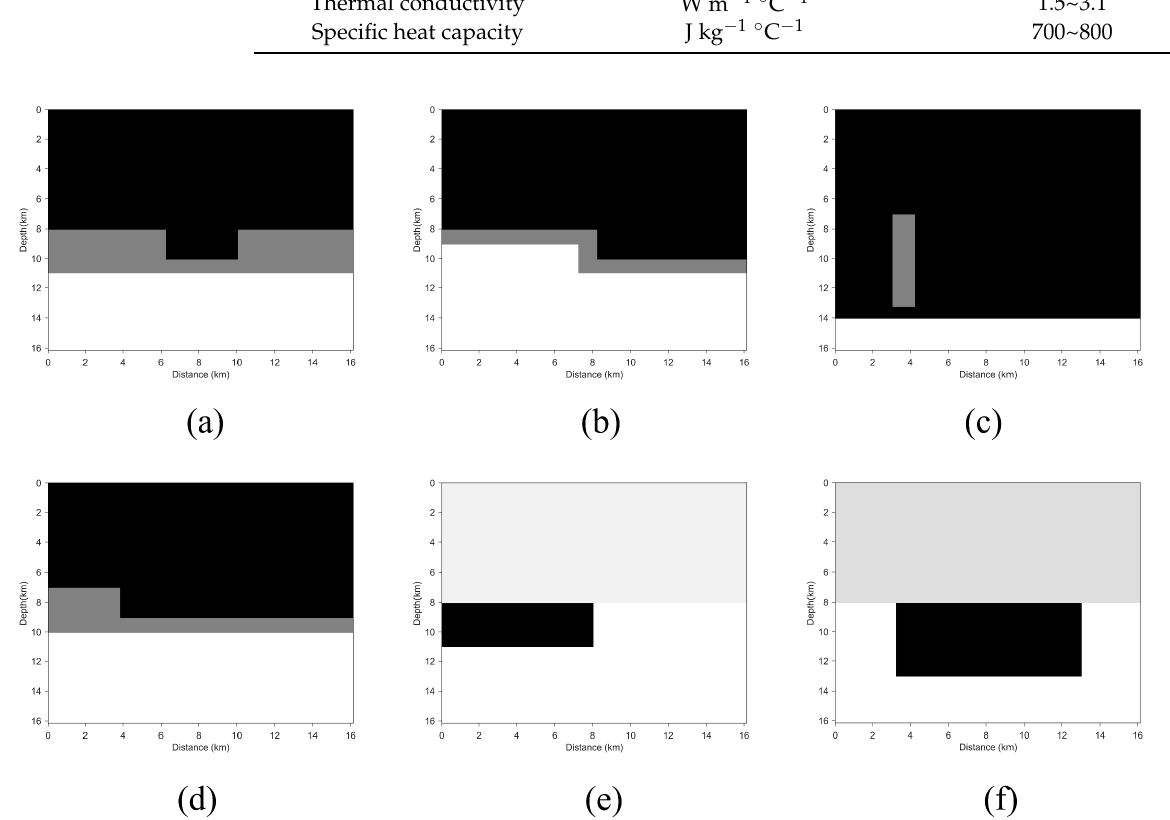
Figure 2. The six randomly selected geological models ( a – f ) from the training data set, ( a – f ) the six geological models contain different geological structures: ( a ) Graben model, ( b ) pleated–structure model, ( c ) magmatic intrusion model, ( d ) platform model, ( e ) magmatic intrusion model, ( f ) magmatic intrusion model. Different geological models enrich the training data set.